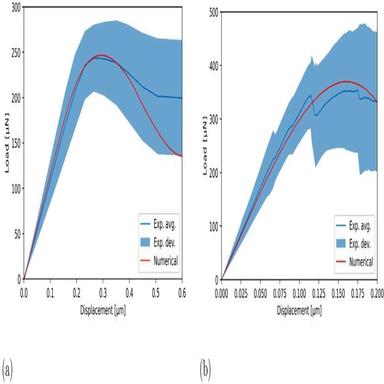
Numerical and experimental results comparisons for Mode I and Mode II testing conditions.